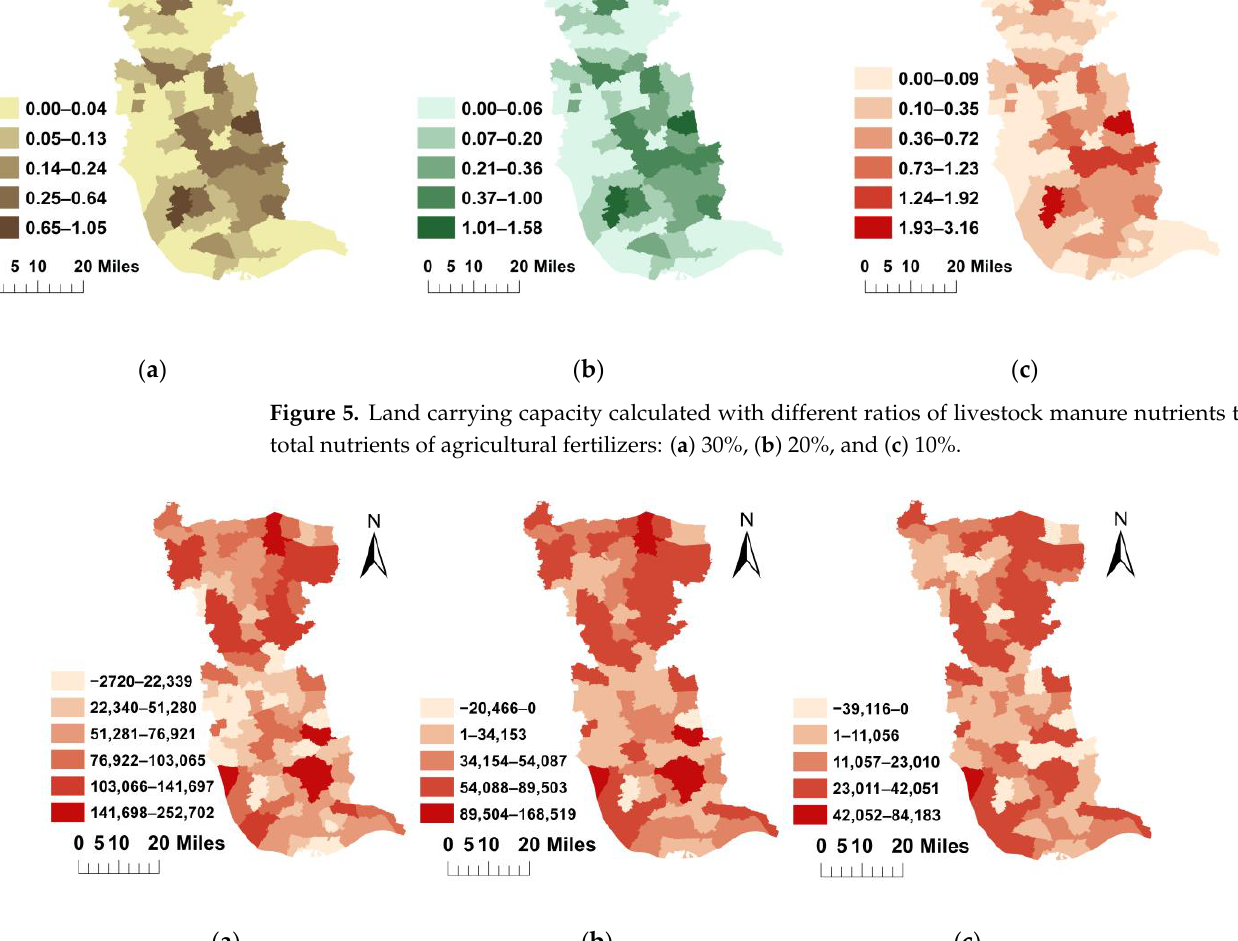
Figure 5. Land carrying capacity calculated with different ratios of livestock manure nutrients to total nutrients of agricultural fertilizers: ( a ) 30%, ( b ) 20%, and ( c ) 10%.